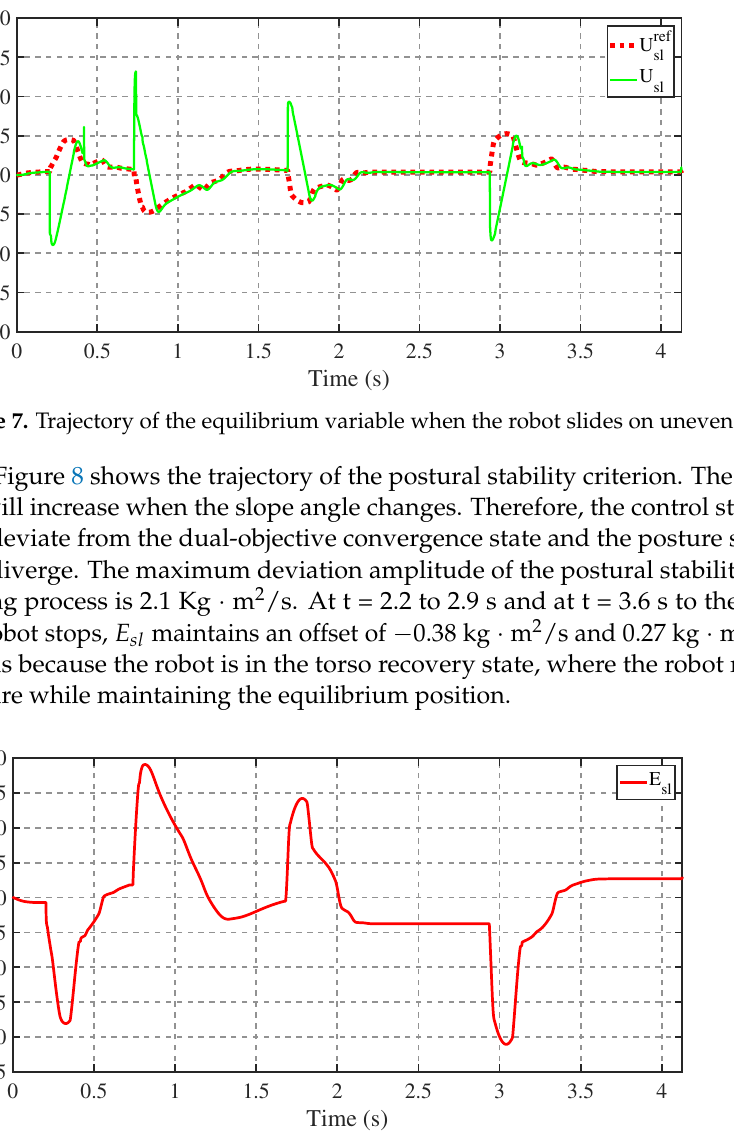
Figure 8. Trajectory of the postural stability criterion when the robot slides on uneven terrain. The trajectory of the torso recovery coefficient is shown in Figure 9. In the sliding process, the maximum time interval between the robot sliding to a new sliding angle and the torso recovery coefficient rising to 1 is 0.43 s. When the robot is in the torso recovery stage, the torso control strategy proposed in this article can adjust the ratio of the torso recovery coefficient to ensure that the amplitude of E sl will not diverge during the sliding process. Figure 10 shows the simulation result for the torso angle. During the sliding process, the torso angle is effectively controlled within 60